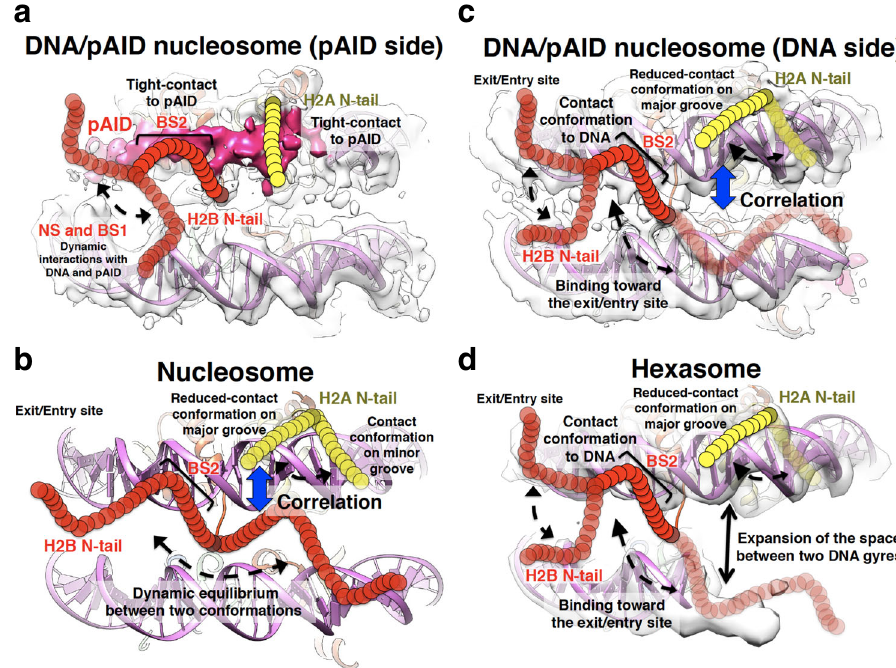
Fig. 8 Summary of the dynamic conformations of the H2A and H2B N-tails. a – d Dynamic structures of the H2A and H2B N-tails in the DNA/pAID nucleosome on the pAID ( a ) and DNA ( c ) sides, in nucleosome ( b ), and in hexasome ( d ), colored as in Fig. 1. In b , the canonical nucleosome structure (PDB ID: 2CV5) is shown. In a , c , the EM density map of the 112-bp DNA/pAID nucleosome (EMD-9639) is superimposed on the nucleosome structure (PDB ID: 2CV5) lacking the 33-bp DNA. In d , the EM density map of the 112-bp hexasome (EMD-6939) is superimposed on the nucleosome structure (PDB ID: 2CV5) lacking the 43-bp DNA and one H2A/H2B dimer. Yellow and red circular chains denote the H2A and H2B N-tails, respectively. Dotted arrows represent the dynamic behavior of the H2A and H2B N-tails. Black arrow represents expansion of the space between two DNA gyres in hexasome, as shown in the cryo-EM structure of the 112-bp hexasome 10 . Blue arrows represent conformational correlation between the H2A N-tail and the H2B